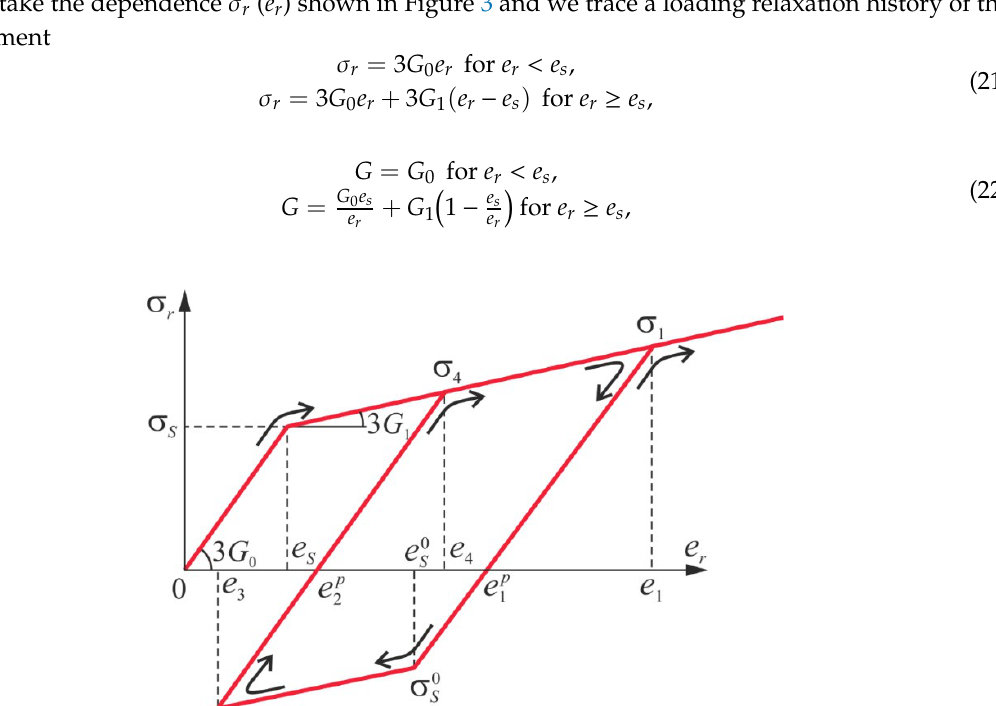
Figure 2. Dependence “load–deflection” ( a ) graphs comparison with different nodes number in the grid; ( b ) in the shell center obtained via the Bubnov–Galerkin method (BGM) in higher accuracy approximation (blue) and finite differences method (FDM) (red). Table 1. Surfaces of deflection and stress of the plate and the shell.